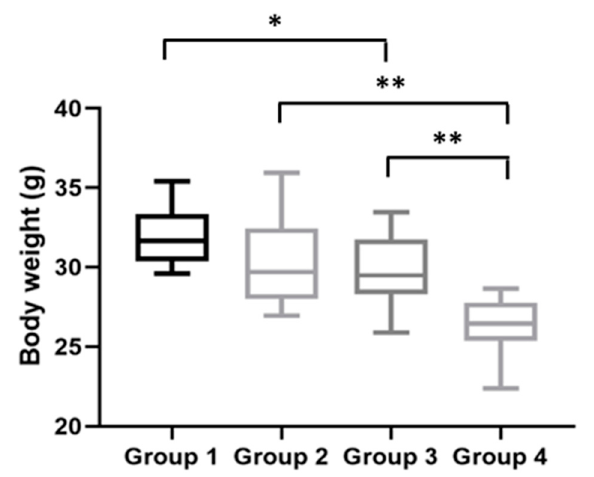
Figure 5. Body weights at the time of sacrifice. HPV + mice had lower body weights than HPV − mice: Group 3 had a statistically significantly lower body weight than Group 1 (* p < 0.05); Group 4 had a statistically significantly lower body weight than Group 2 (** p < 0.01). Between the HPV + mice, mice with DMBA (Group 4) had a lower body weight than mice without DMBA (Group 3) (** p < 0.01). Group 1: HPV − without DMBA application ( n = 10); Group 2: HPV − with DMBA application ( n = 10); Group 3: HPV + without DMBA application ( n = 10); Group 4: HPV + with DMBA application ( n = 10).